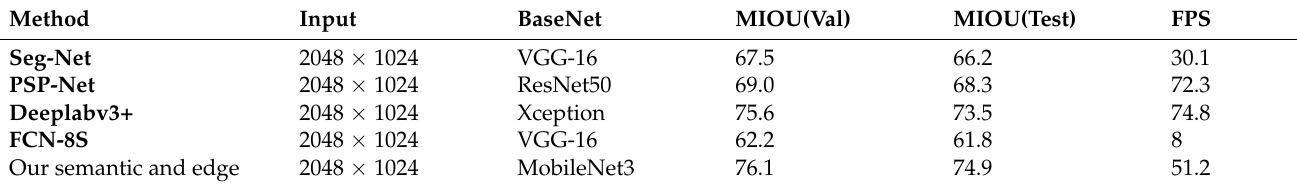
Our semantic and edge feature fusion network, together with FCN-8s, Seg-Net, PSP- Net, and Deeplabv3+, were used on the CamVid dataset for the object segmentation experiment. The experimental results are shown in Table 4. Table 4. Accuracy and speed of image semantic segmentation network on CamVid